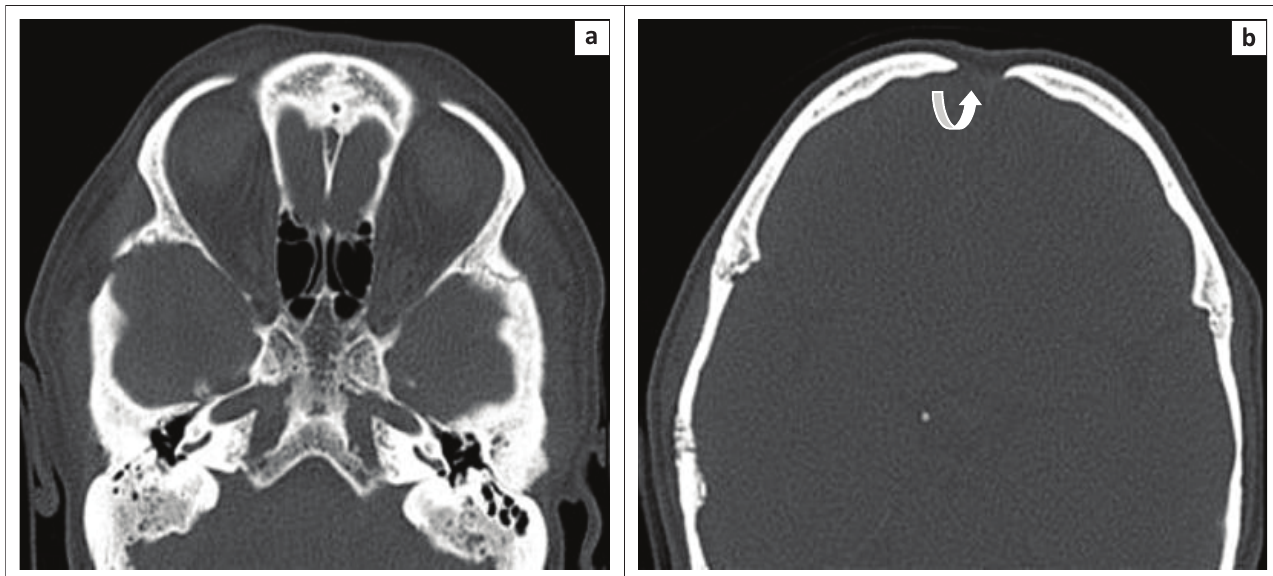
FIGURE 6: Axial-computed tomography section at the level of skull base (a) shows under-pneumatised mastoids, non-pneumatised sphenoid sinuses and superiorly (b) shows an open metopic suture (curved